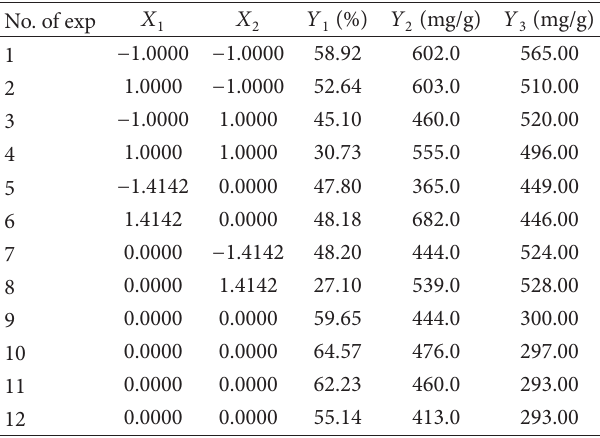
T 2: Experimental design matrix and the corresponding exper- imental